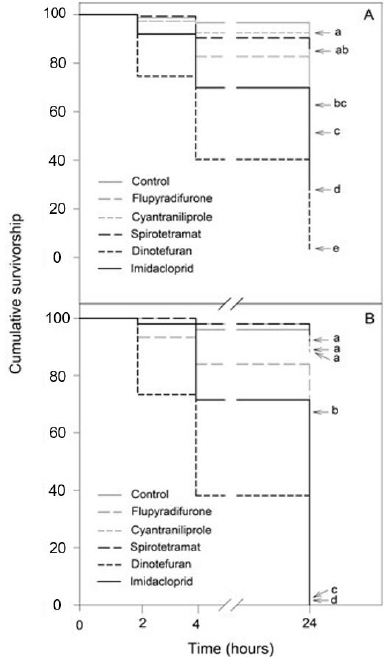
Figure 2. Kaplan–Meier survivorship curves of stingless bees orally exposed to 10-fold diluted commercial formulation of the selected insecticides: dinotefuran, 60 mg L −1 ; imidacloprid, 70 mg L −1 ; flupyradifurone, 68 mg L −1 ; spirotetramat, 30 mg L −1 ; and cyantraniliprole, 20 mg L −1 . The figure displays Nannotrigona perilampoides ( A ) and Frieseomelitta nigra ( B ). The estimated survival functions were compared with a nonparametric Log-Rank test (Holm–Sidak method). Significant differences ( p < 0.05) among insecticide treatments are indicated by different